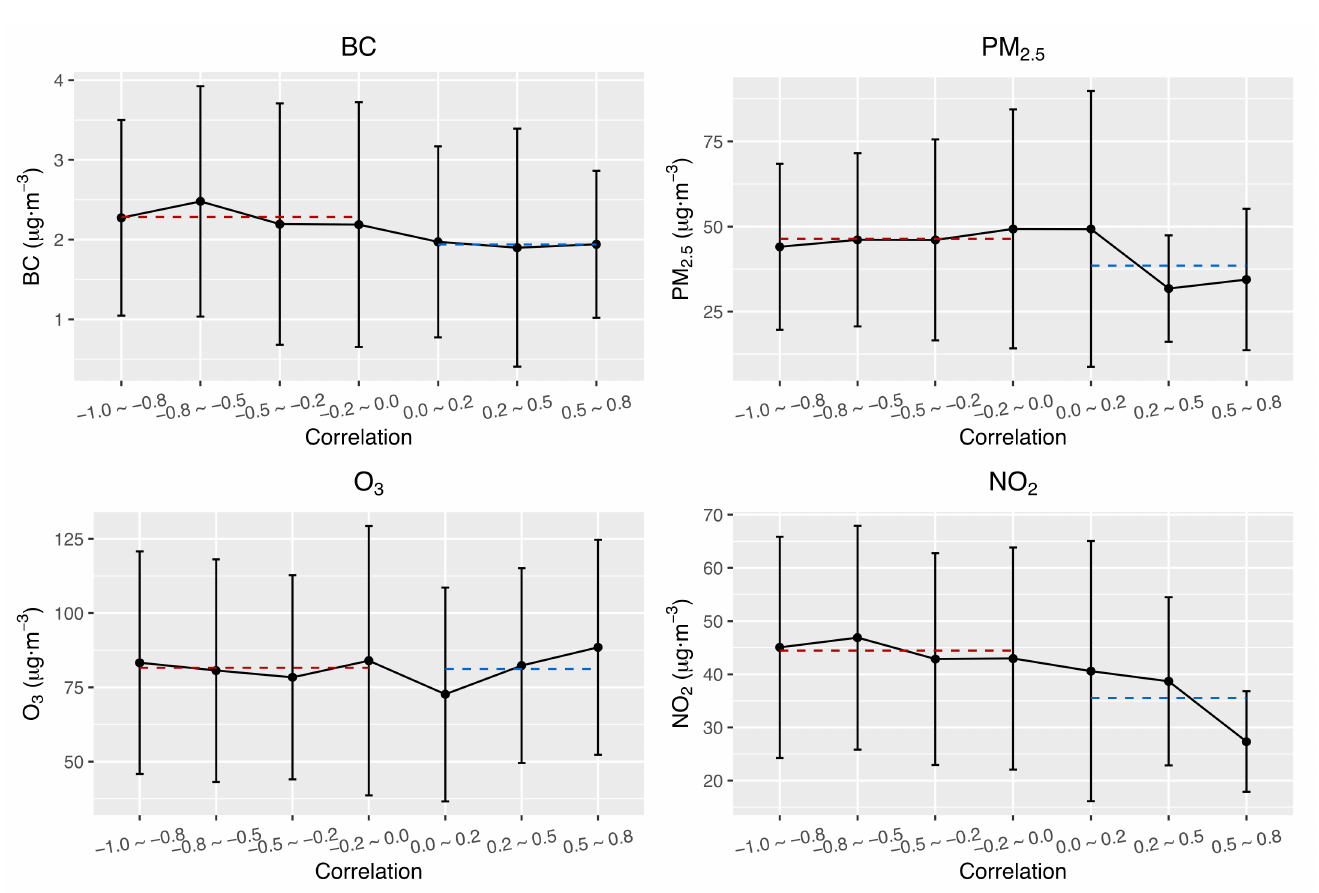
Figure 5. Mass concentrations of pollutants (BC, PM 2.5 , O 3 , NO 2 ) under different levels of